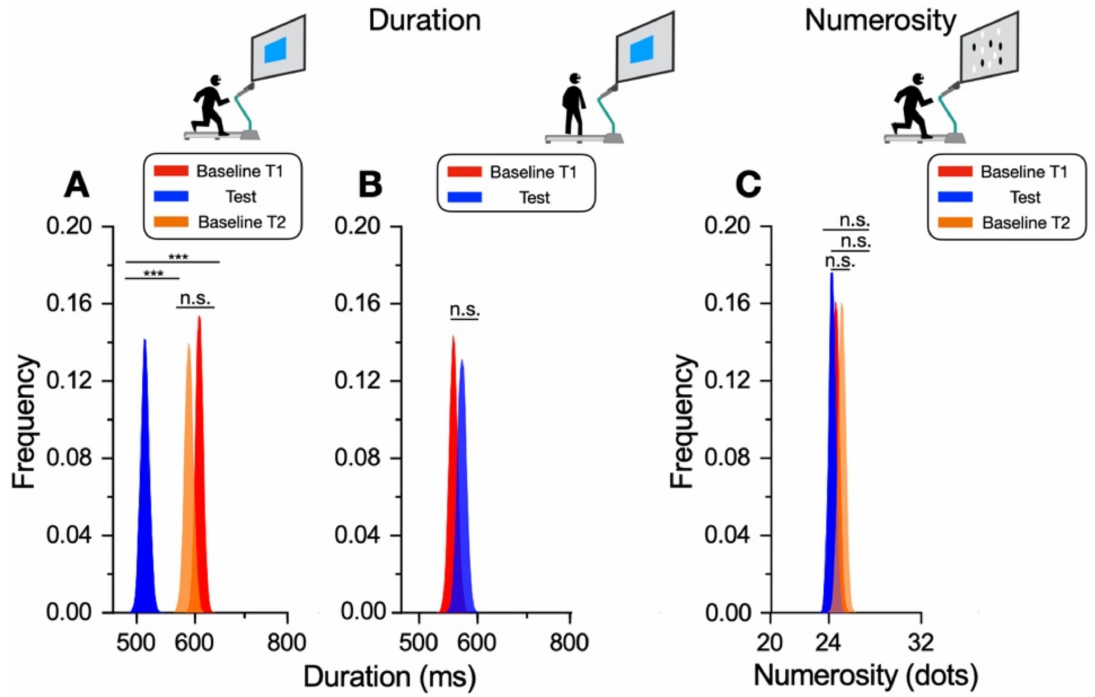
Figure 4. Bootstrap Z-test on aggregate data. Distributions of fitted peaks for the duration ( A , B ) and numerosity ( C ) tasks. Overlapped distributions indicate no difference between conditions. p -values represent Z-test significance level: *** p < 0.01 > α = 0.017, Bonferroni corrected for three comparisons.